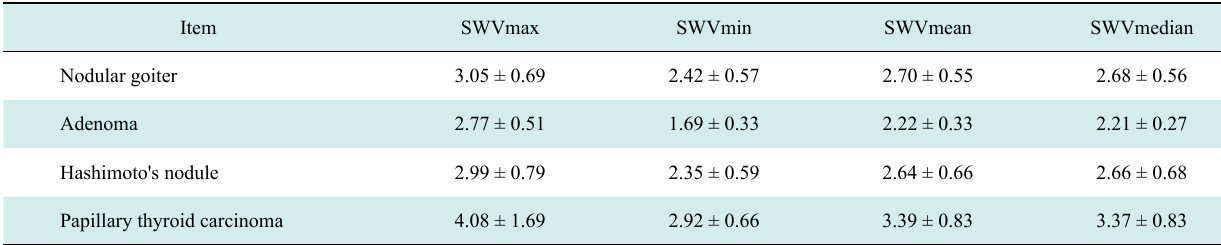
Figure 1 Flowchart of patients’ selection in this Table 1 The various SWV values in nodules with different pathological types (m/s)